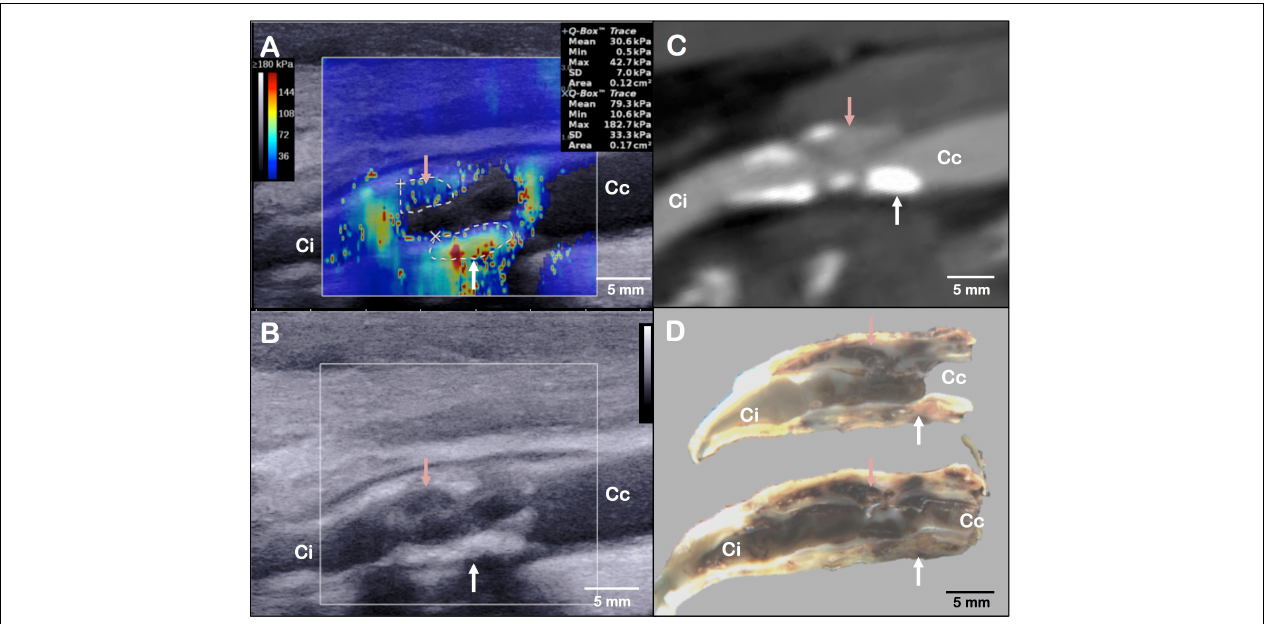
FIGURE 1 | Layout of elastography assessment (A) , B-mode ultrasound acquisition (B) , computed tomography angiography (C) and gross examination (D) of the same plaque in a longitudinal axis view. The red arrow indicates the main haemorrhagic area on panel (D) . It corresponds to a low stiffness (A) , hypoechogenic (B) and low-density (C) area. The white arrow indicates a fibrous and calcified area on panel (D) . It corresponds to a high stiffness (A) , hyperechogenic (B) and high-density (C) area. Ci, internal carotid; Cc, common carotid.